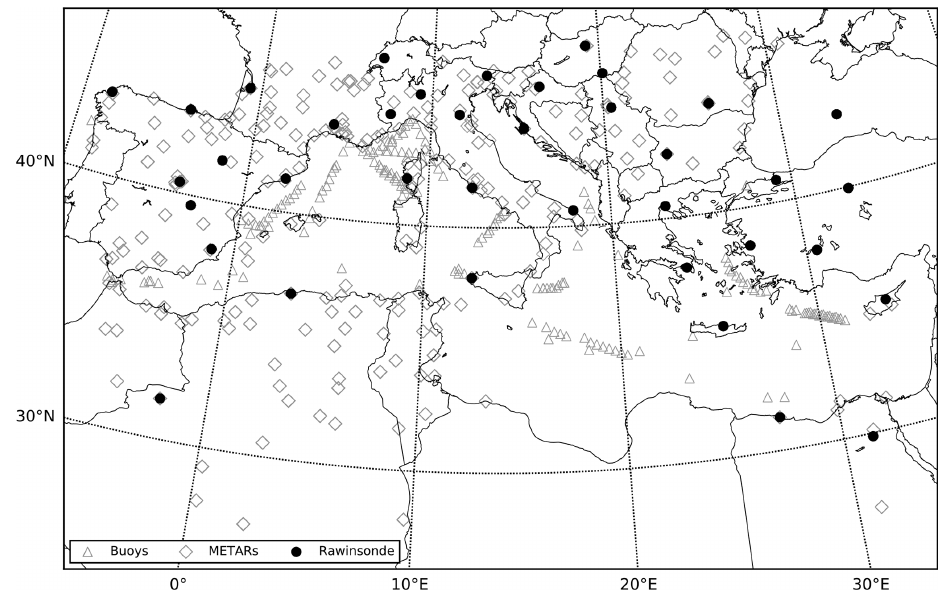
Figure 4. Spatial distribution of in situ conventional observations from the MADIS database (buoys, METARs and rawinsondes) assimilated every hour between 12:00UTC on 6 November and 00:00UTC on 7 November